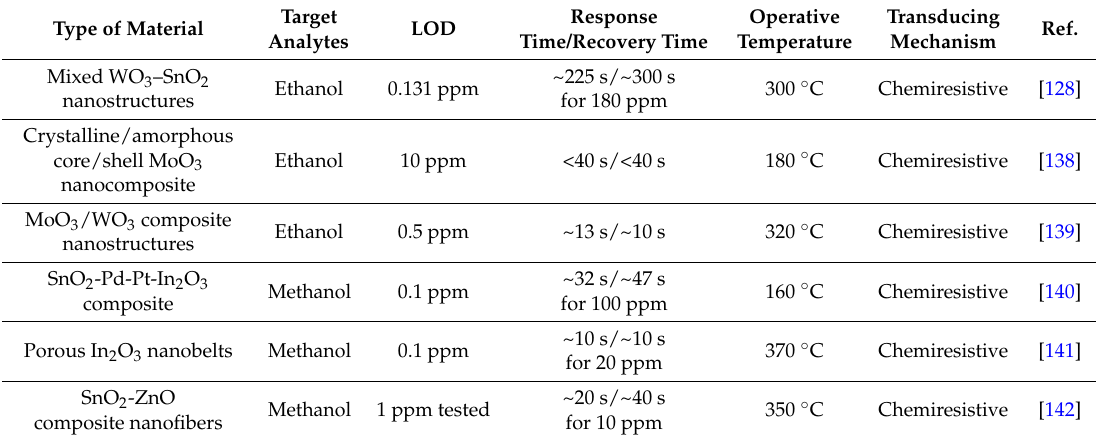
Table 7. Overview of different nanomaterials used as active layers for detection of other gases and VOC. Target Type of Material Analytes